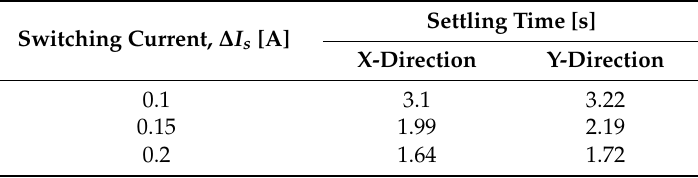
Table 1. Settling time in lateral directions with different switching